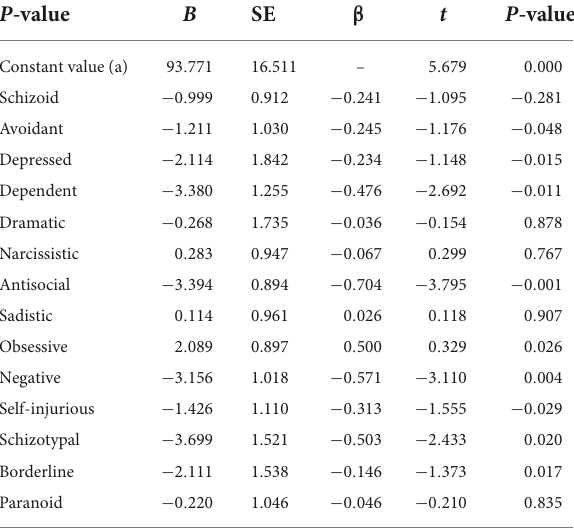
TABLE 5 Results of regression analysis of predicting self-care behaviors by personality